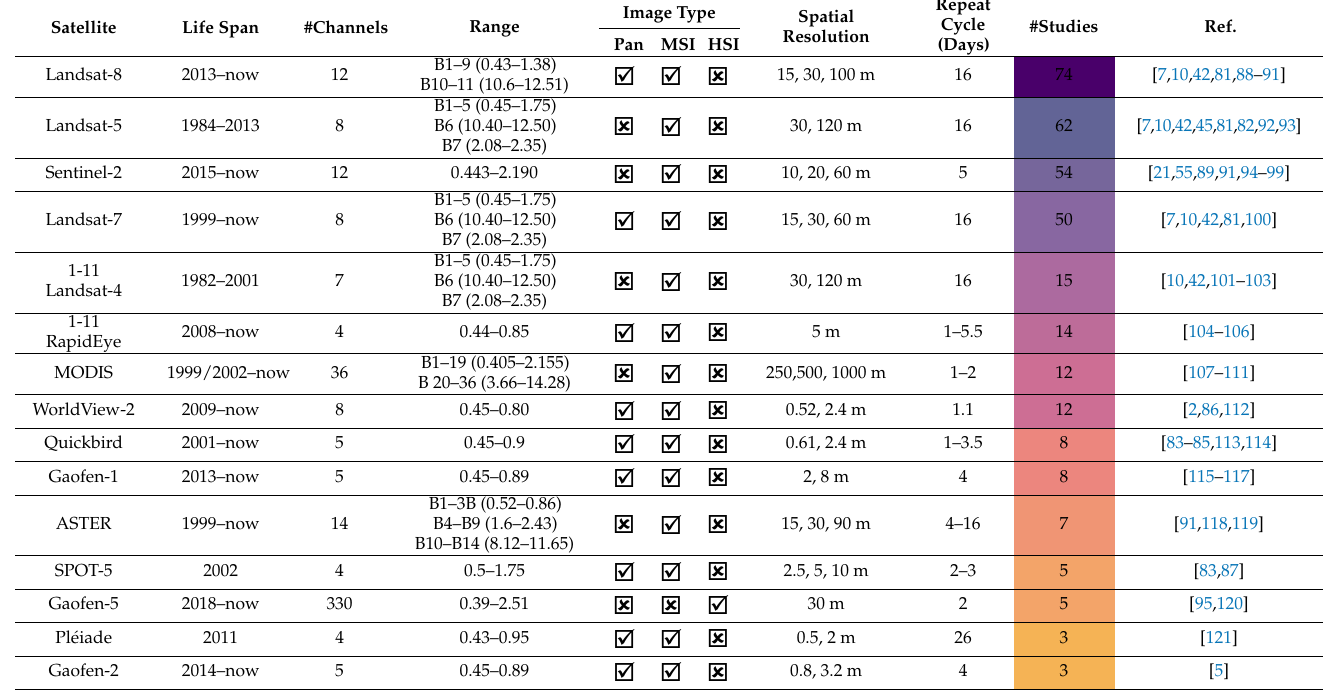
Table 6. List of the commonly used SAR satellites wetland studies, ranked by the number of times they have been utilized in the